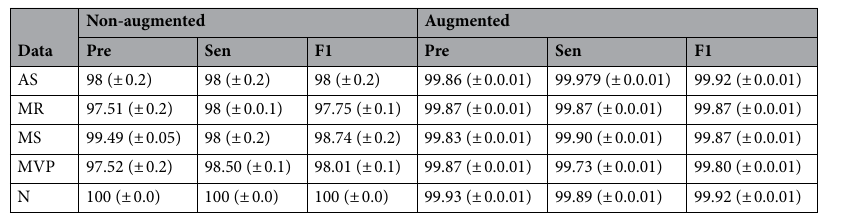
Table 10. Comparison of the performance metrics of augmented and non-augmented datasets. Pre precision, Sen sensitivity, F1 F1-score.